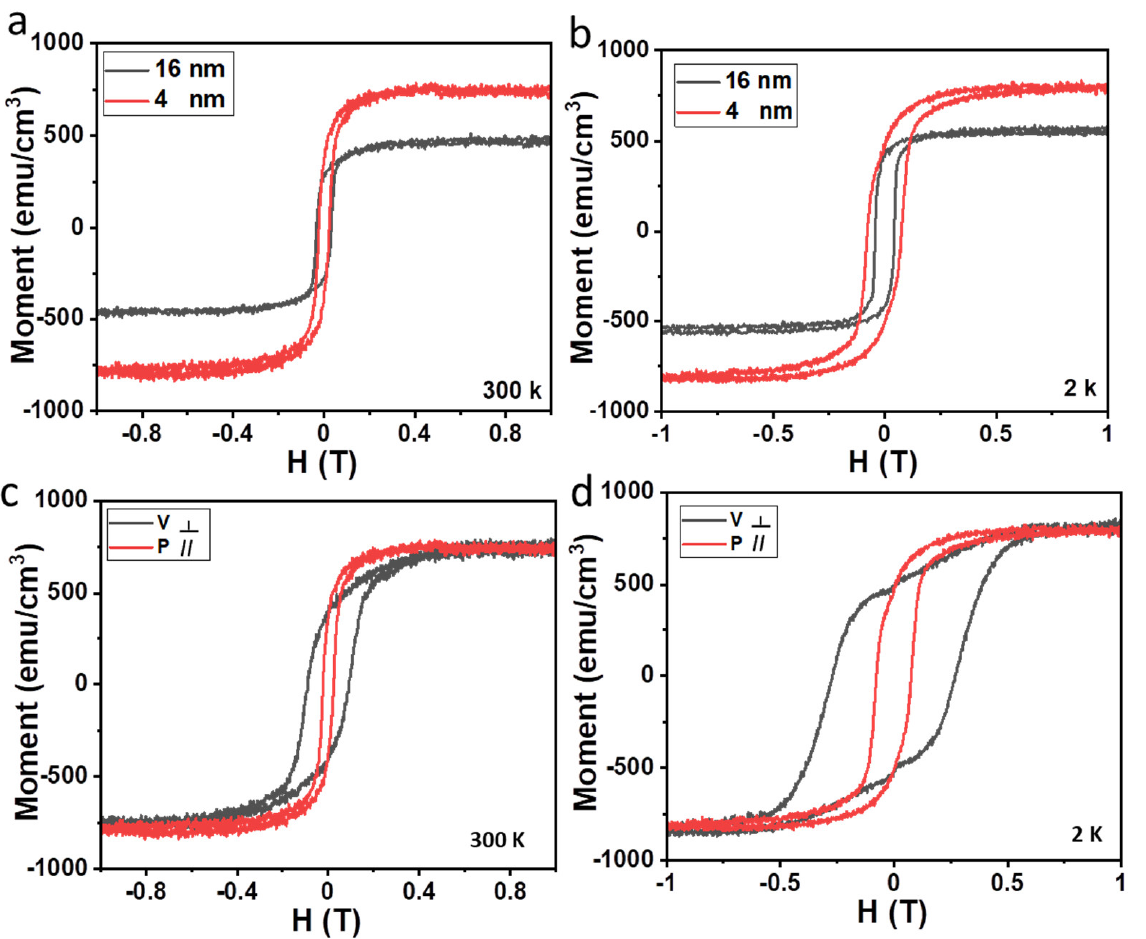
Figure 4. In-plane magnetic hysteresis loops of Fe 3 O 4 films with the thicknesses of 4 nm and 16 nm measured at 300 K ( a ) and 2 K ( b ). In-plane and out-of-plane magnetic hysteresis loops of 4 nm Fe 3 O 4 films measured at 300 K ( c ) and 2 K ( d ). Table 1. Saturation magnetization and thickness of Fe 3 O 4 films synthesized by different methods.